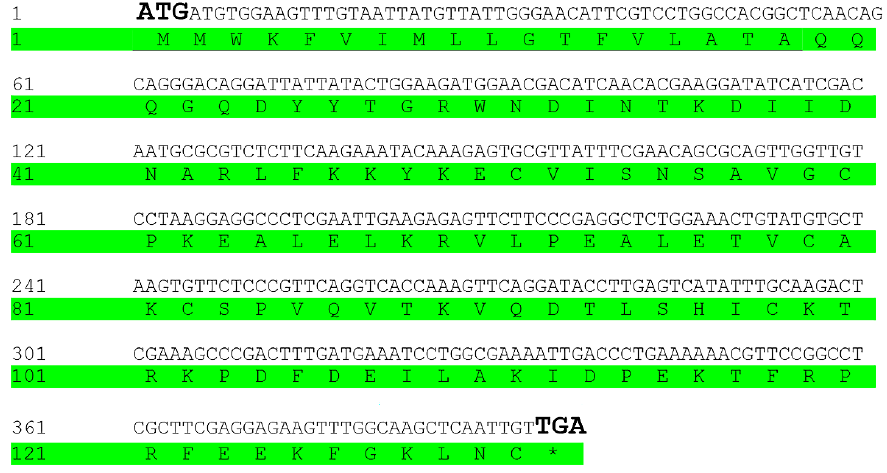
Figure 2. Nucleotide and deduced amino sequences. The start and stop codons are shown in bold type, the asterisk marks the translation termination codon, and the predicted signal peptide is underlined. Table 3. Information on the biochemical properties of SnitCSP4.